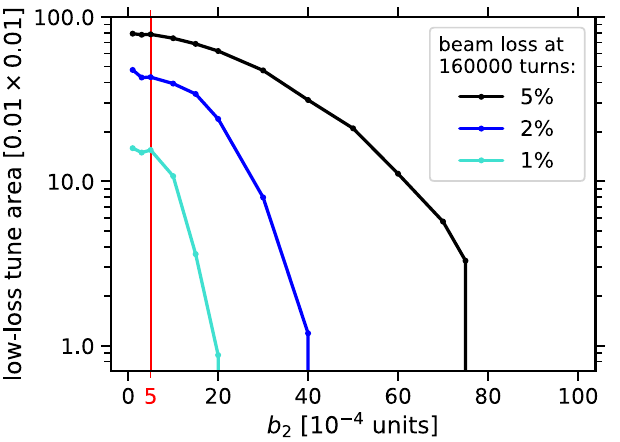
FIG. 15. Size of low-loss area as a function of stochastically distributed b 2 in the quadrupole magnets (dipole magnets are set to b 2 ¼ 0 ). The three curves show the < 1% , < 2% , and < 5% beam-loss areas, respectively.